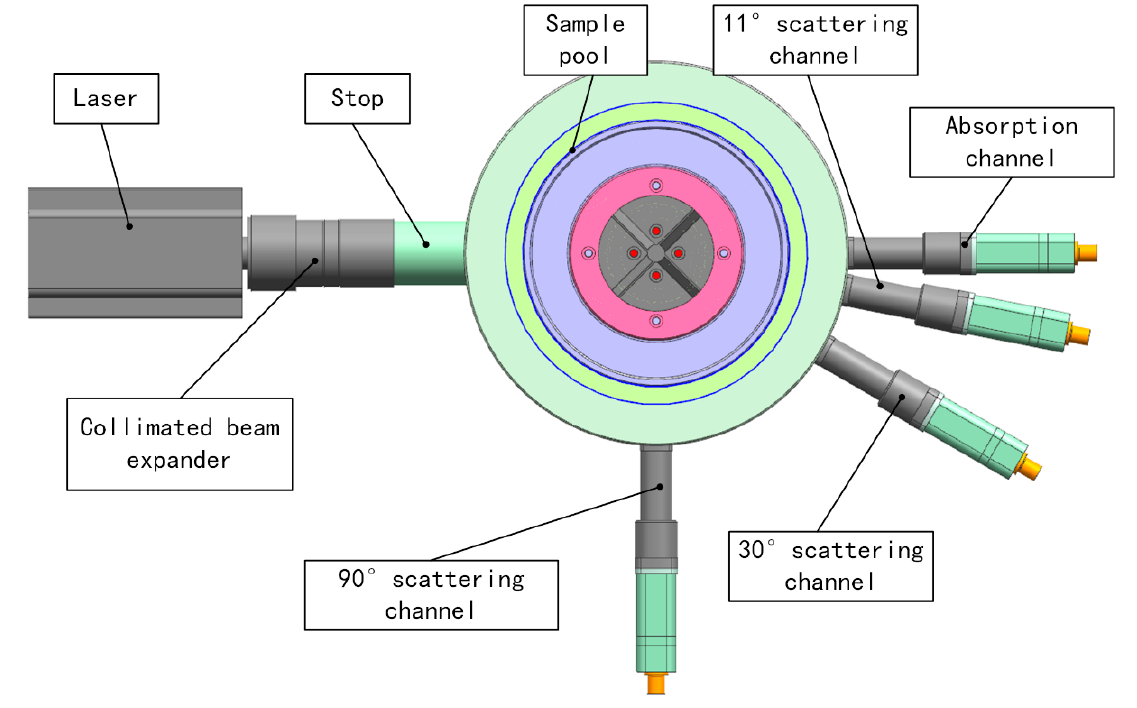
Figure 10. The drawing of the optical system.